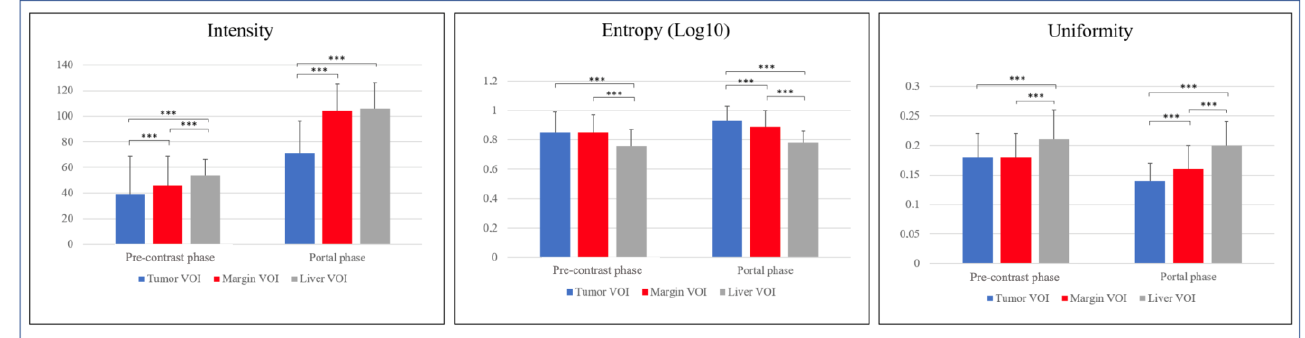
Figure 4. Comparison of intensity, entropy, and uniformity of Tumor volume of interest (VOI) vs. Margin VOI vs. Liver VOI in the pre-contrast and portal phase. *** p < 0.001.